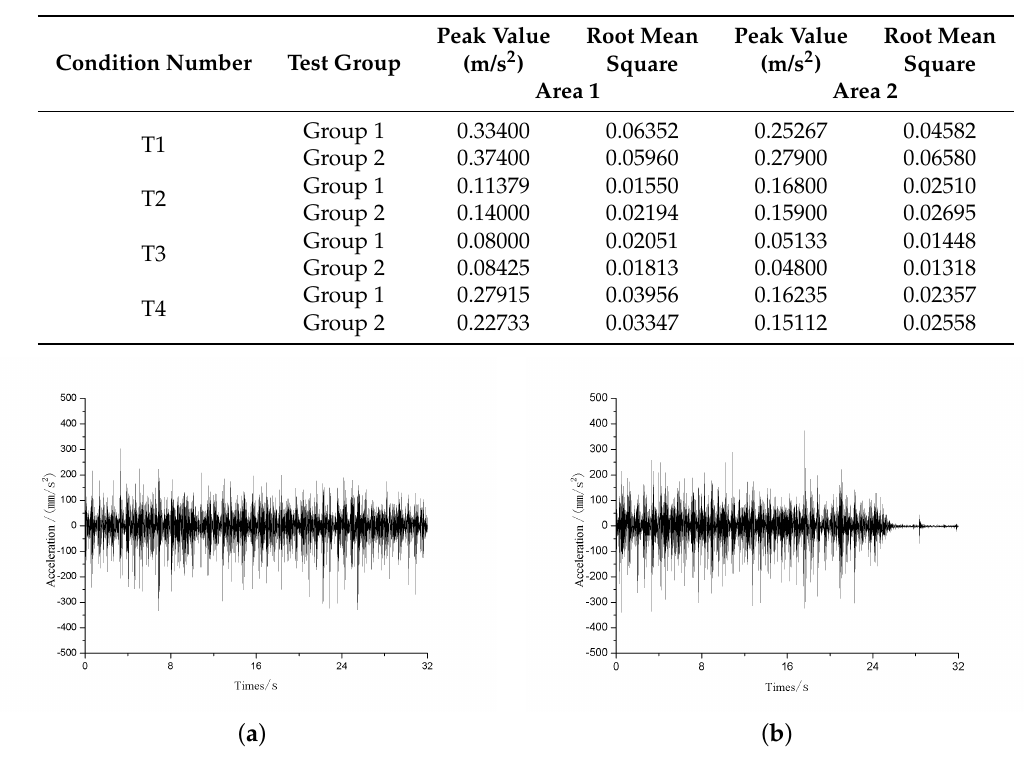
Table 7. Statistical time-domain results of vertical vibration acceleration.